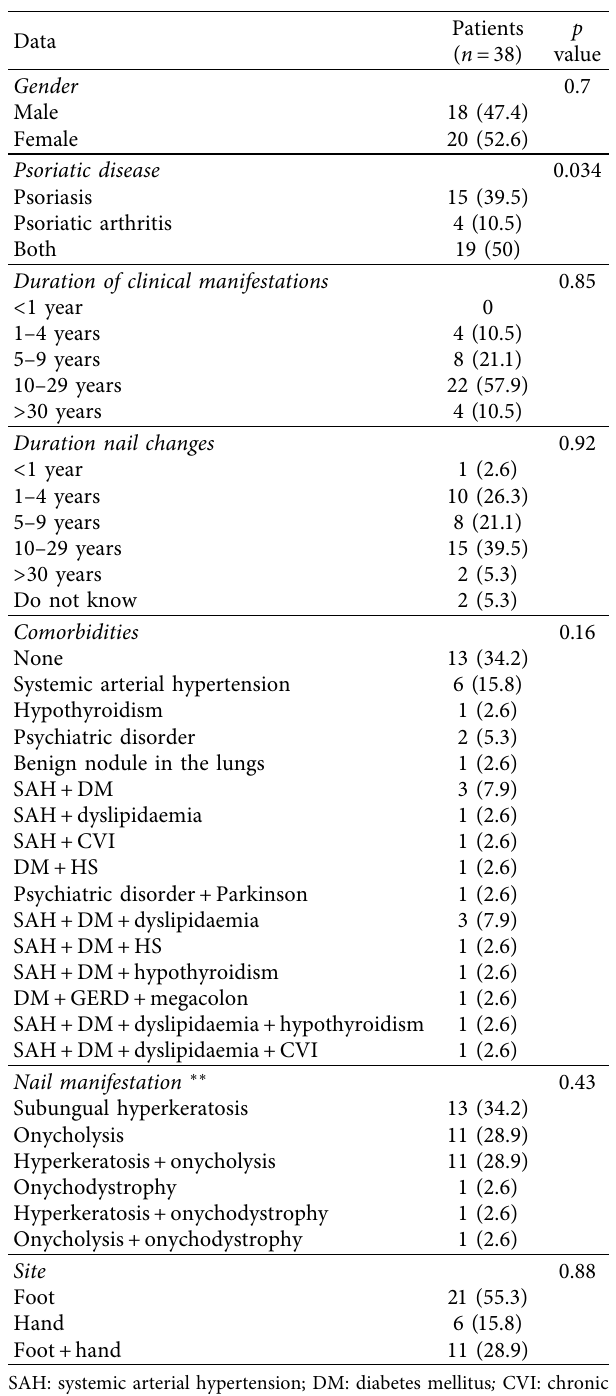
Table 1: Characteristics of the psoriatic